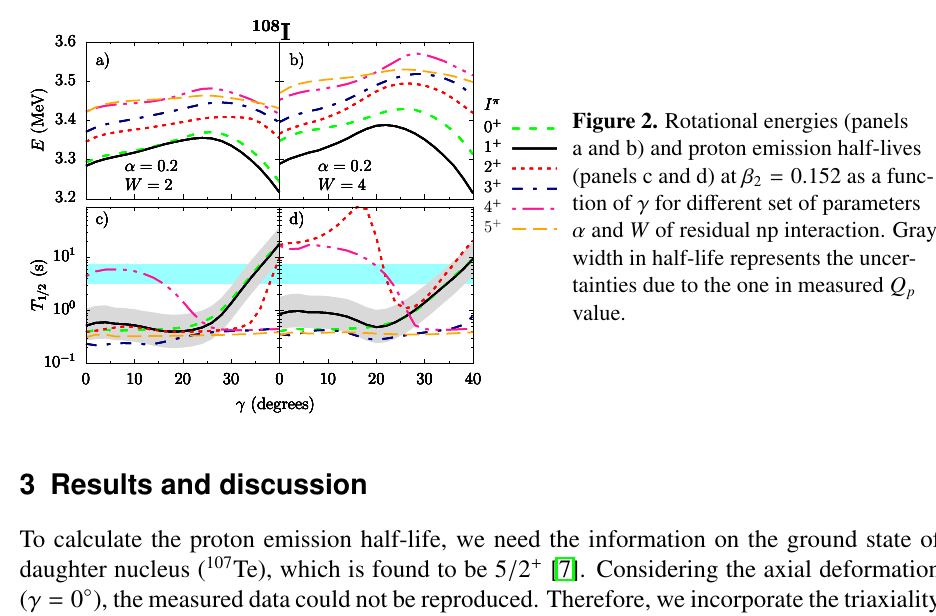
Figure 1. Single-particle (top) and quasiparticle (bottom) energies of neutrons in 107 Te (left) and protons in 107 I (right) at β 2 = 0 . 152 as a function of γ . Positive and negative parity levels are represented by the solid and dashed lines, respectively. Green and yellow lines represent the Fermi level and the chemical potential from BCS calculations, respectively.